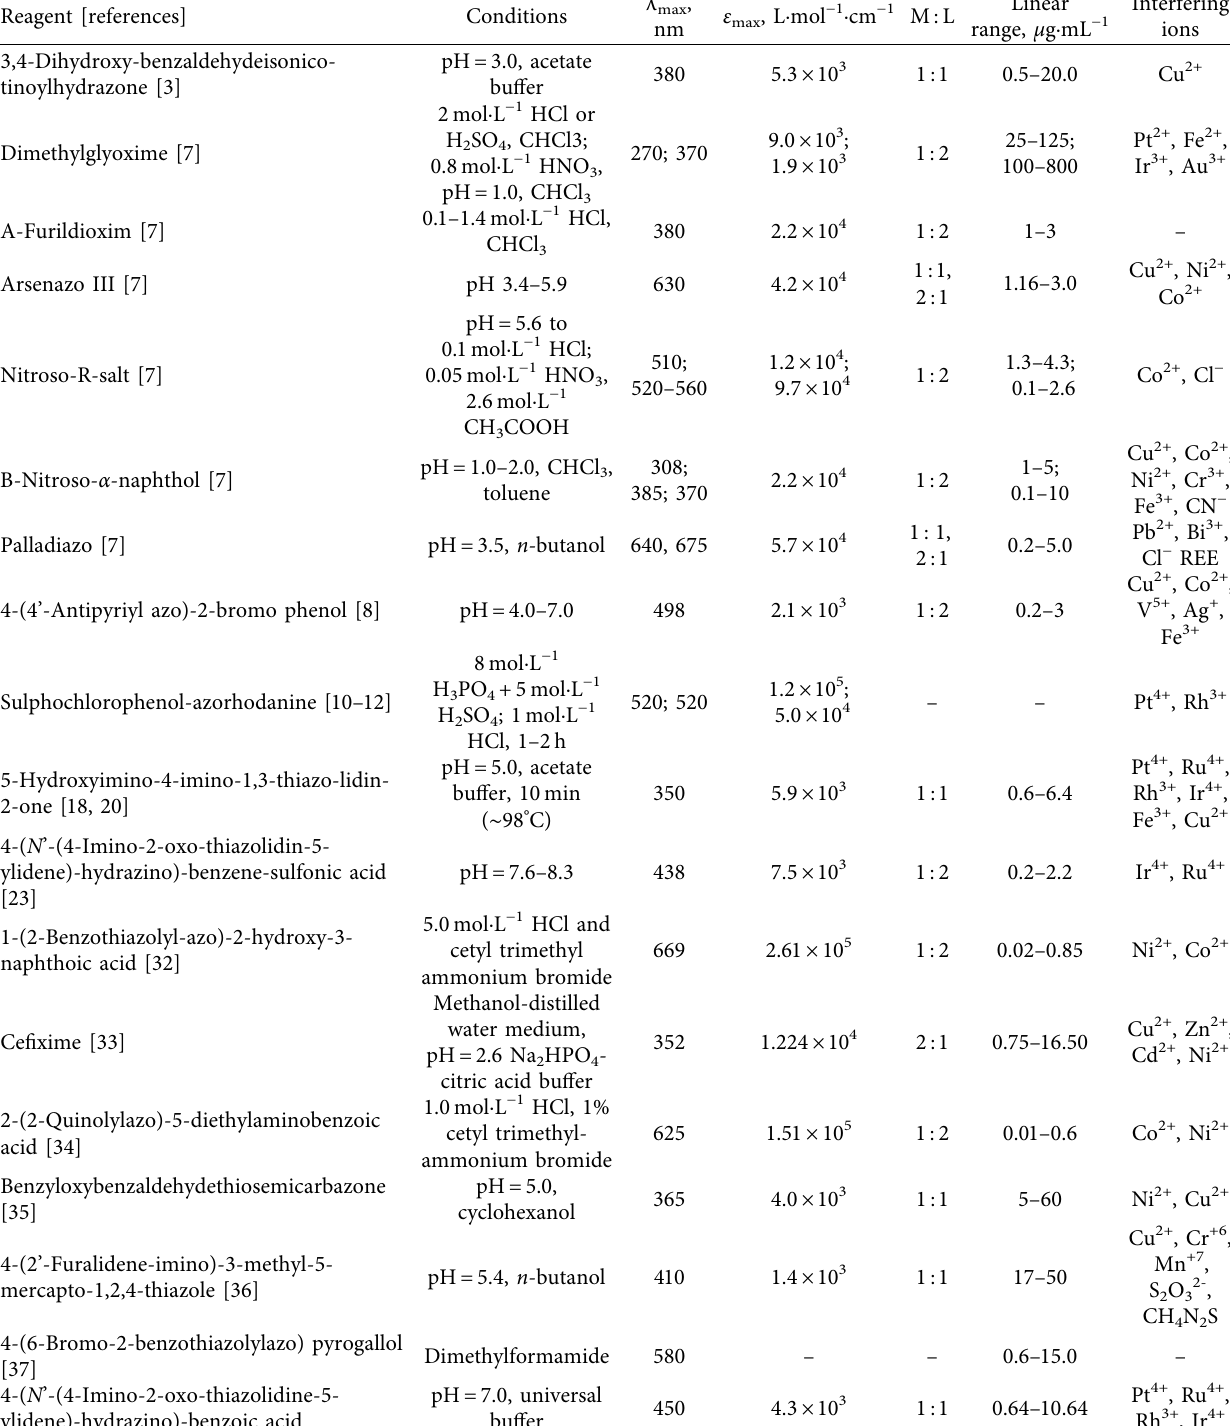
Table 2: Comparison of the present method with other spectrophotometric methods for Pd(II)